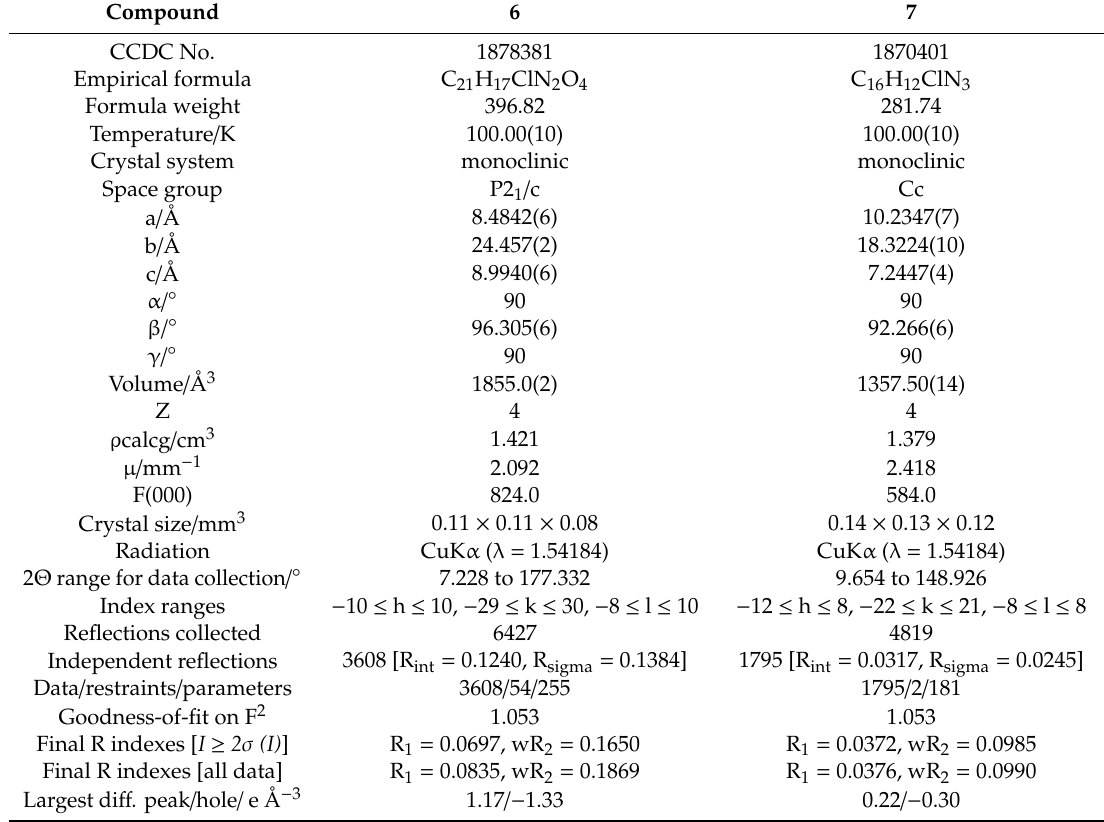
Table 1. Crystal data and structural refinements of compounds 6 and 7